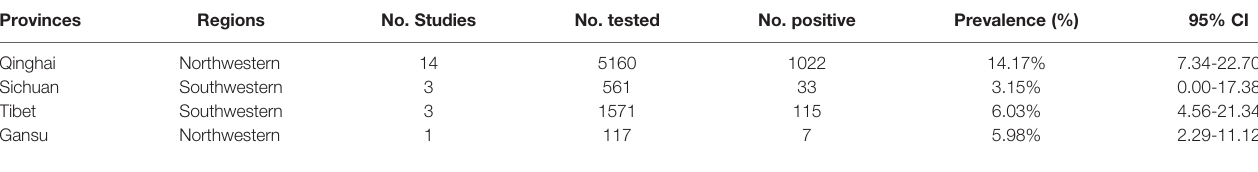
TABLE 3 | Pooled Cryptosporidium prevalence in yaks in various provinces. Provinces Regions No. Studies No. tested No. positive Prevalence (%)